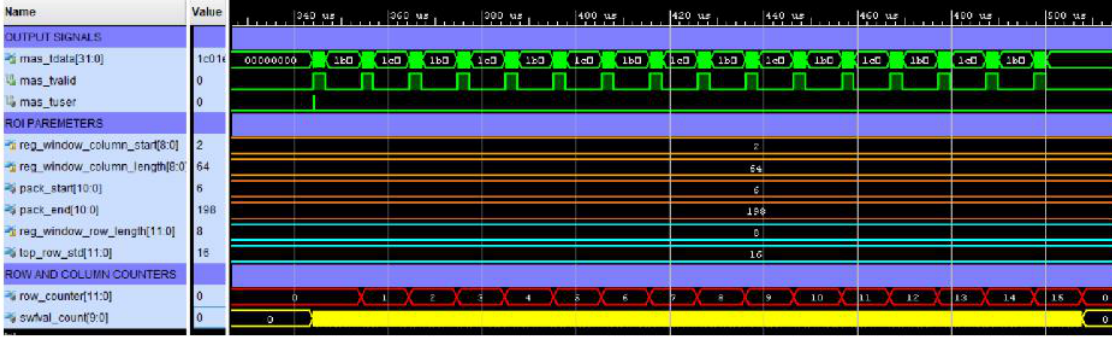
Figure 17. Simulation the image_tx module for a 16 × 512 image.